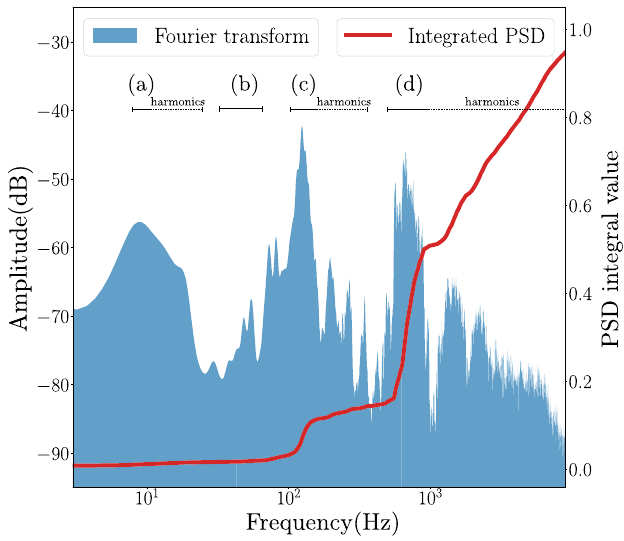
Fig. 2. Typical Fourier transform. In this case, the experimental conditions were: N = 6 , m = 0 . 3 g, l = 2 . 7 mm, e = 2 . 4 mm, f rot = 3 . 7 Hz and R = 9 . 8 cm. Four identifiable zones (a), (b), (c), (d). Only (c) and (d) are audible as showed by the PSD (Power Spectral Density) integral. (a) Is the macroscopic sound produced by the balloon pushing air during its movement. (b) Is the sound components ranging from 30 to 80 Hz. (c) Is the first eigenfrequency of the membrane. (d) Is the frequency produced by the nut rolling and hitting the membrane. Harmonics are also